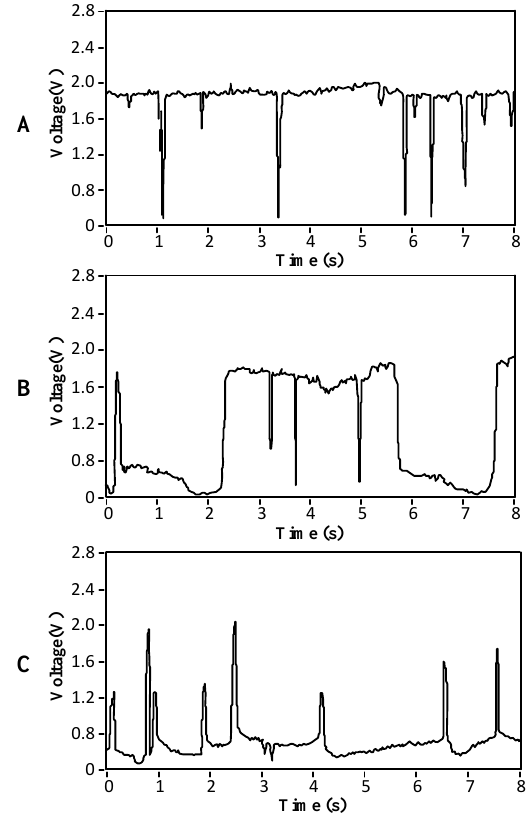
Figure 4. Graph of the two-phase flow pattern. ( A ) Bubble flow; ( B ) slug flow or churn flow; ( C ) annular flow or fine-beam annular flow graph.